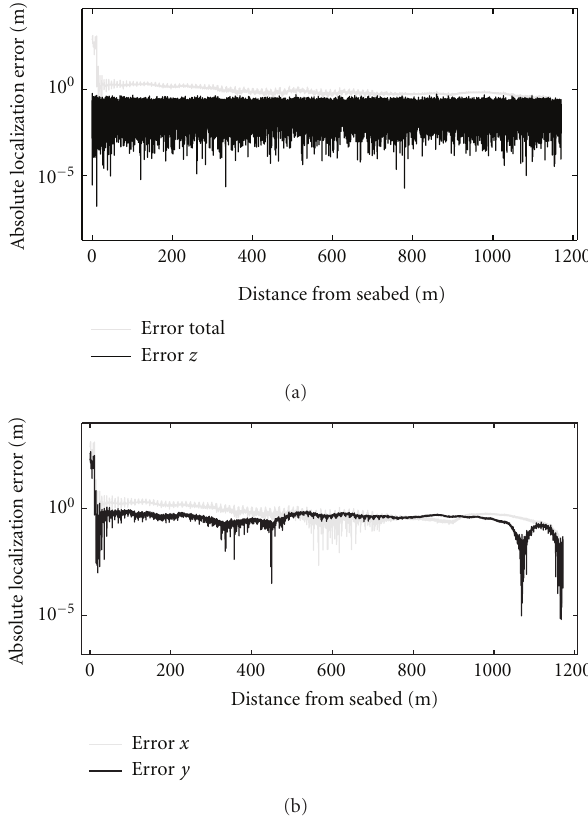
Figure 15: Localization error (in global coordinates) as a function of the distance from the seabed, for the dynamic